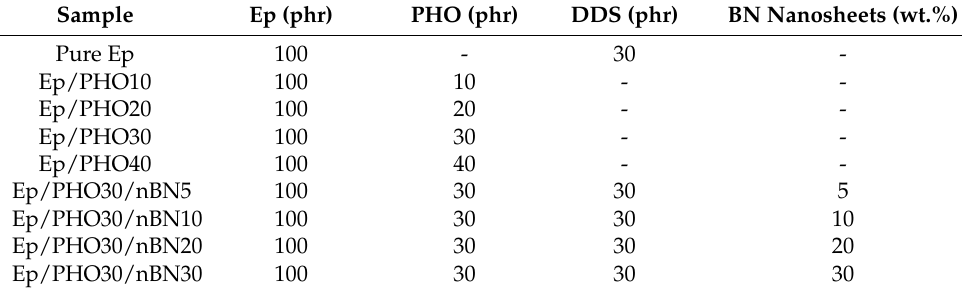
Table 1. Formula-modified epoxy resin and epoxy